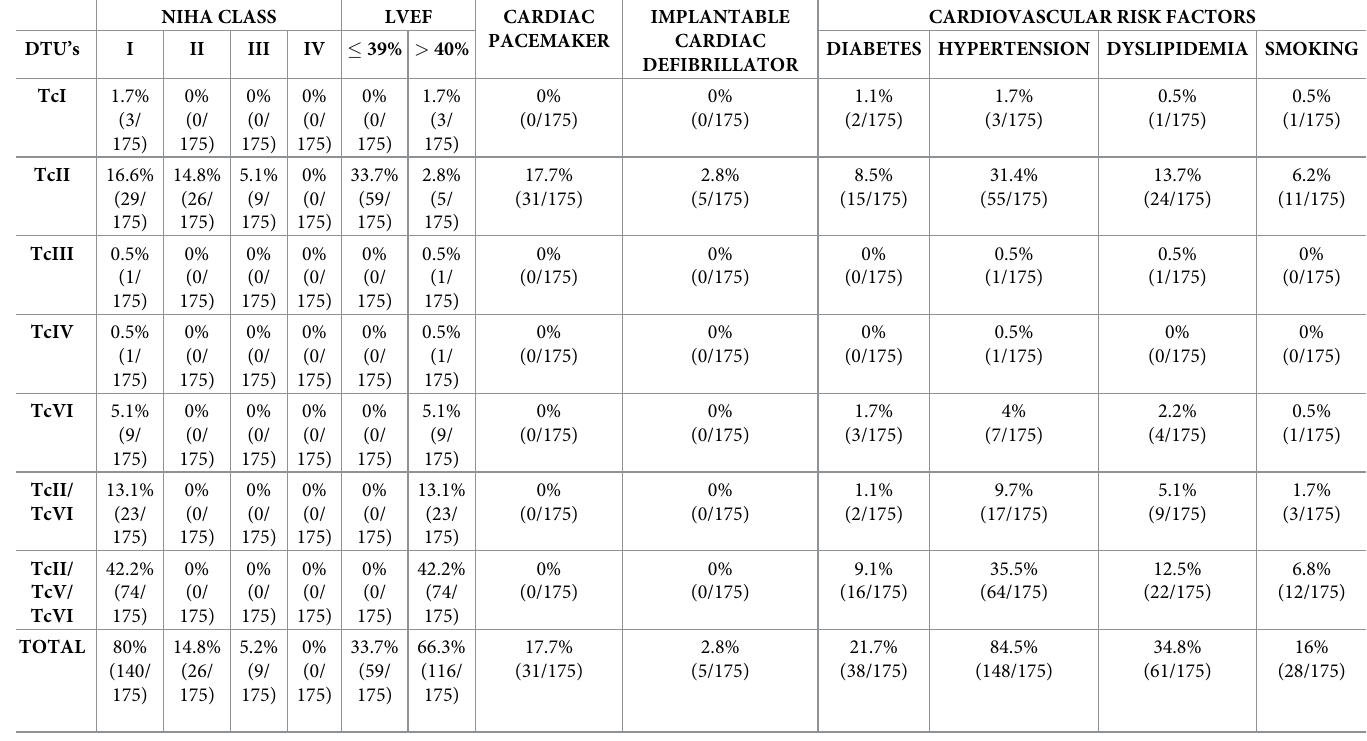
Table 2. Clinical parameters, parasite genetics and cardiovascular risk factors present in 175 patients with Chronic Chagas Cardiomyopathy. NIHA